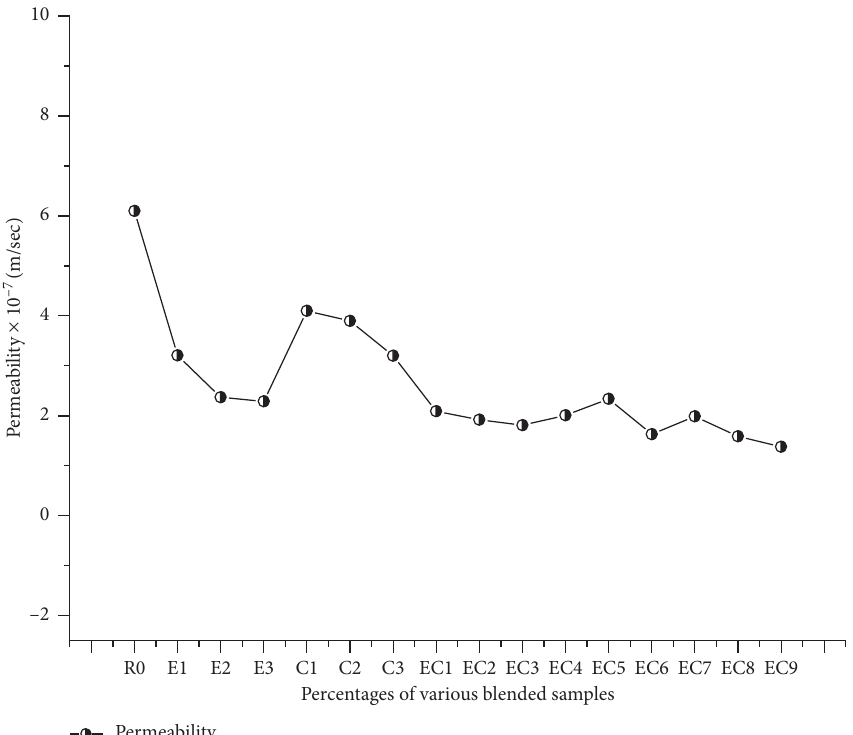
Figure 11: Permeability of soil mixtures with the incorporation of various percentages of cement and